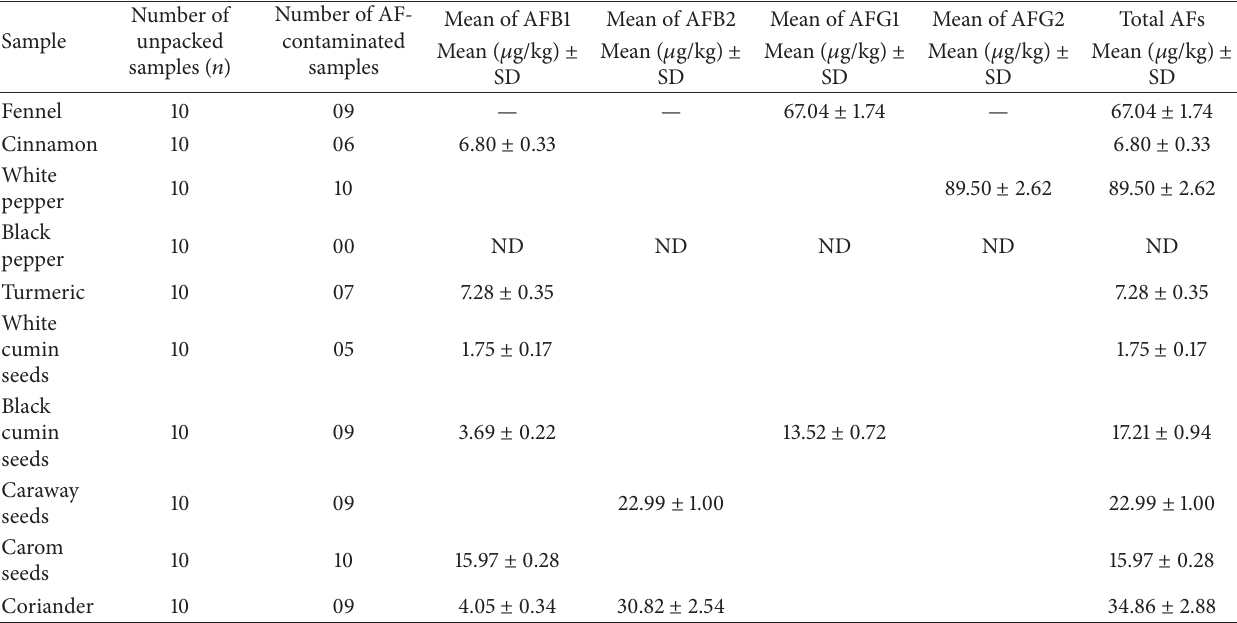
Table 3: Incidence of aflatoxins in unpacked spice